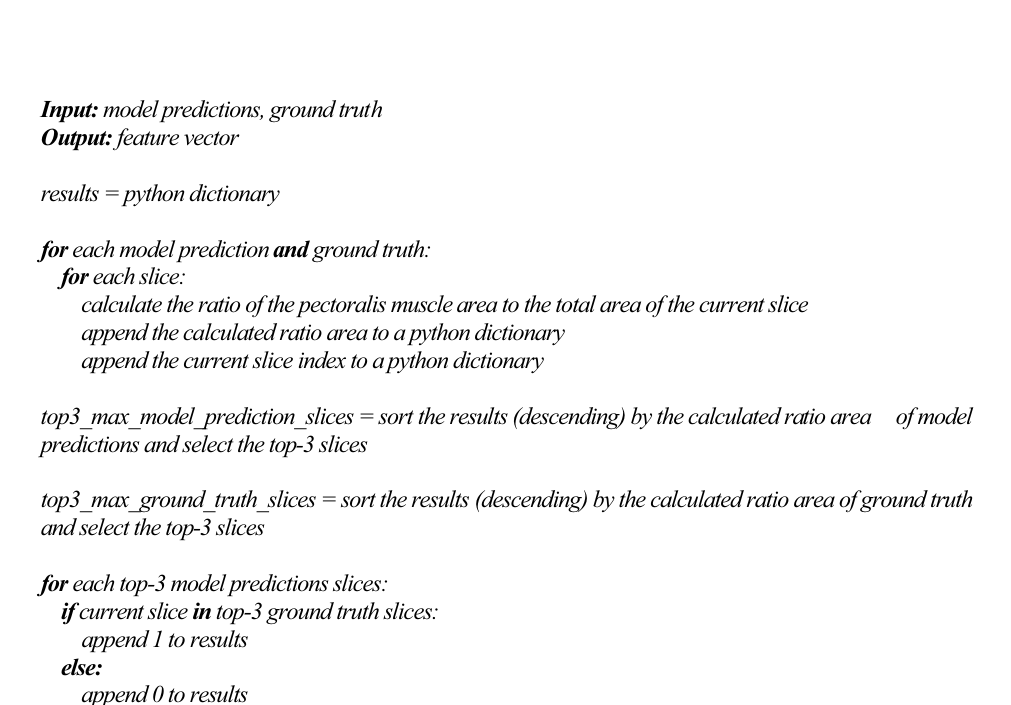
Table 3. Recent studies with deep learning-based MRI for musculoskeletal